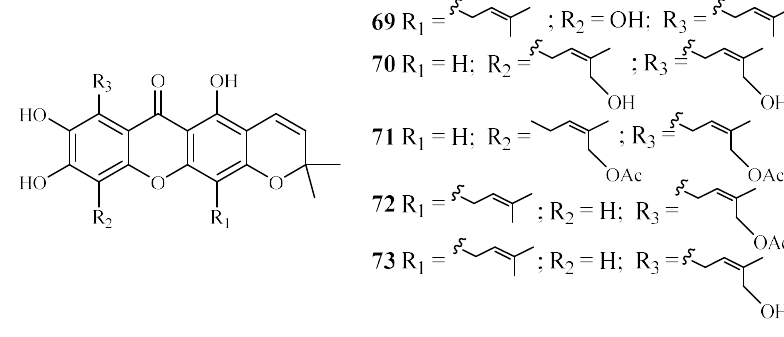
Figure 11. Compounds from a Clusiaceae plant.